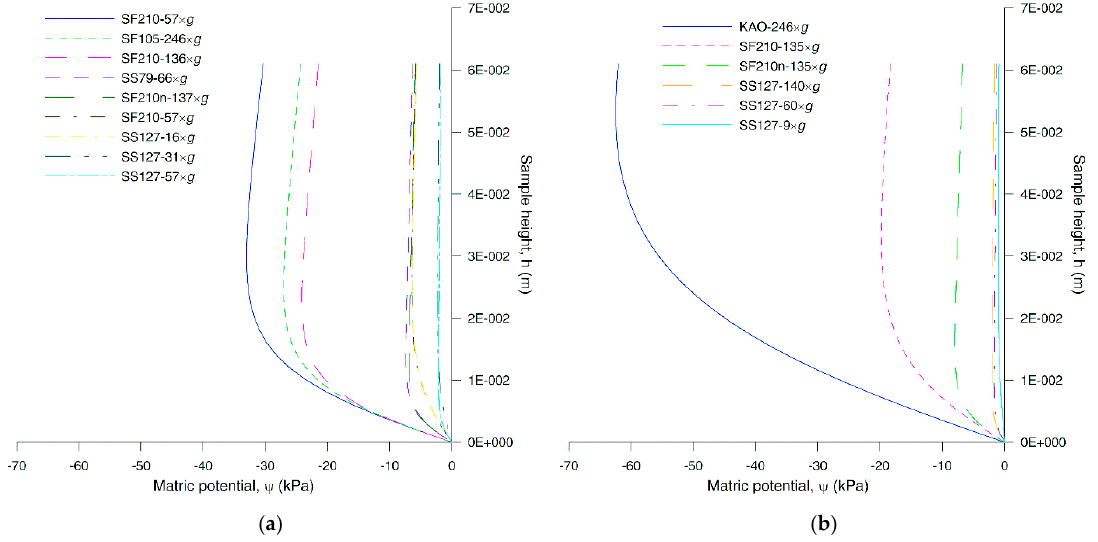
Figure 5. Matric potential profiles along the sample height computed by the KOPCEN calculation code: ( a ) lithotype C; and ( b ) lithotype M.